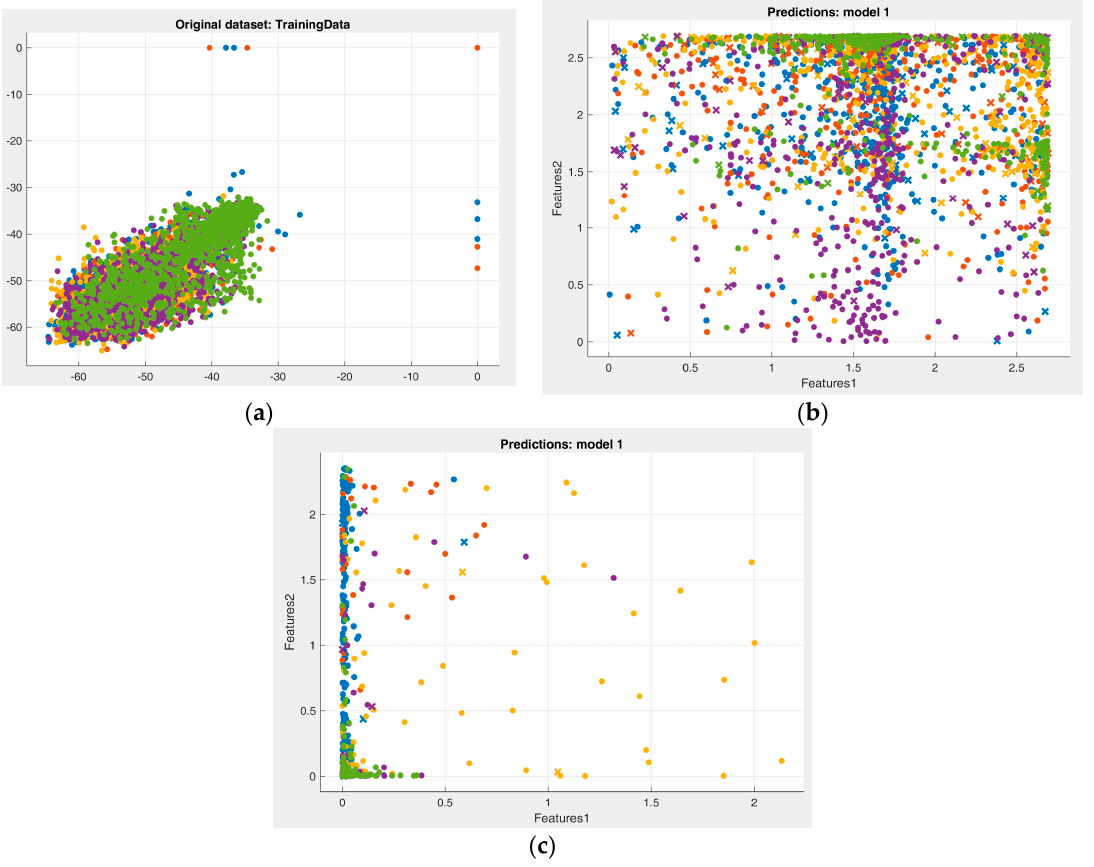
Figure 5. ( a ) MFCCs Features data pattern; ( b ) DWT Features data pattern; ( c ) DWT plus MFCCs Features data pattern.